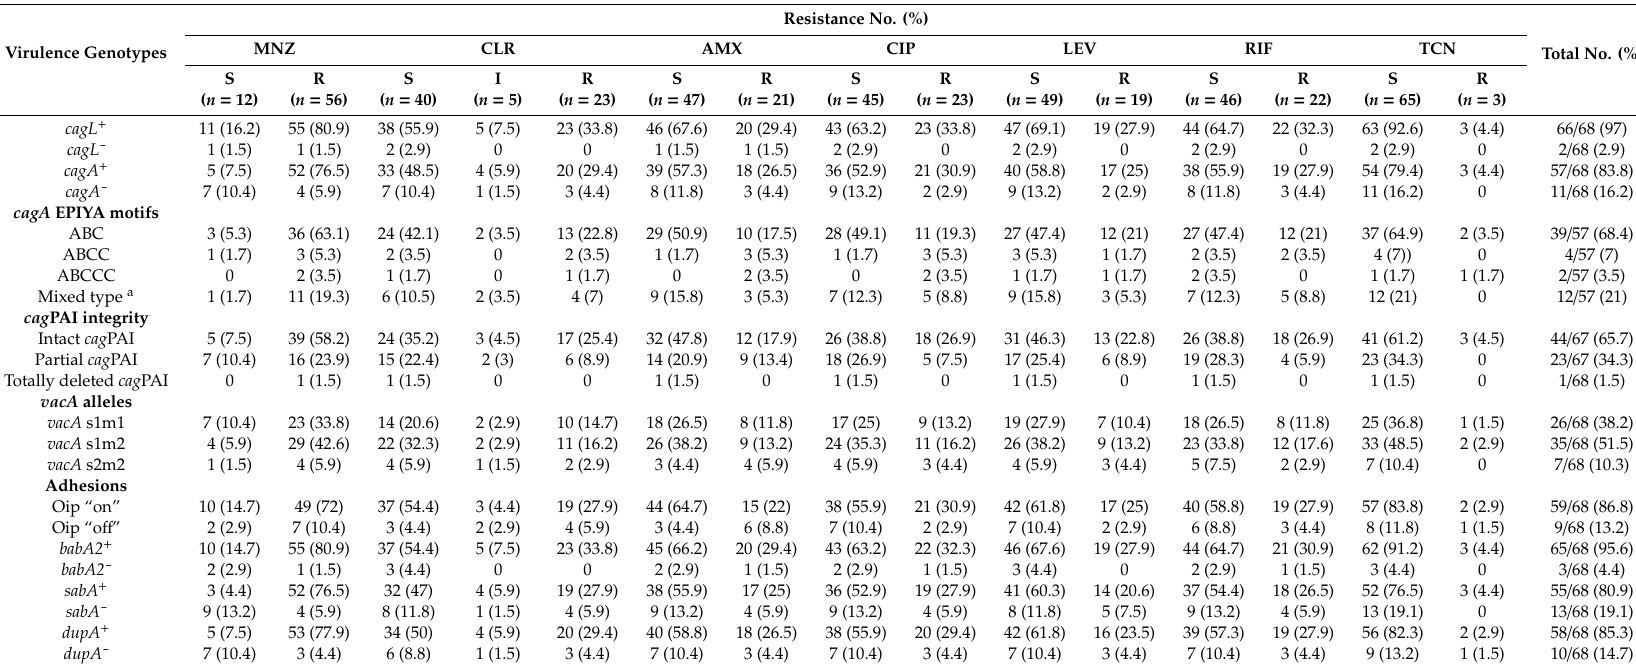
Table 8. Frequency and distribution of virulence genotypes in relation to antibiotic resistance patterns among H. pylori isolates used in this